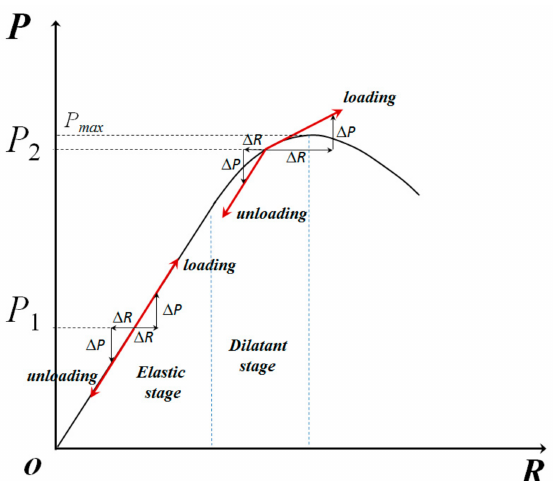
Figure 1. Schematic diagram of the constitutive relation of rock. P and R represent the load and response, respectively. At the stage of P 1 , the responses ( ∆ R ) to the small changes of ∆ P in the loading and unloading are almost the same, while at the stage of P 2 , the response to the loading is significantly greater than the